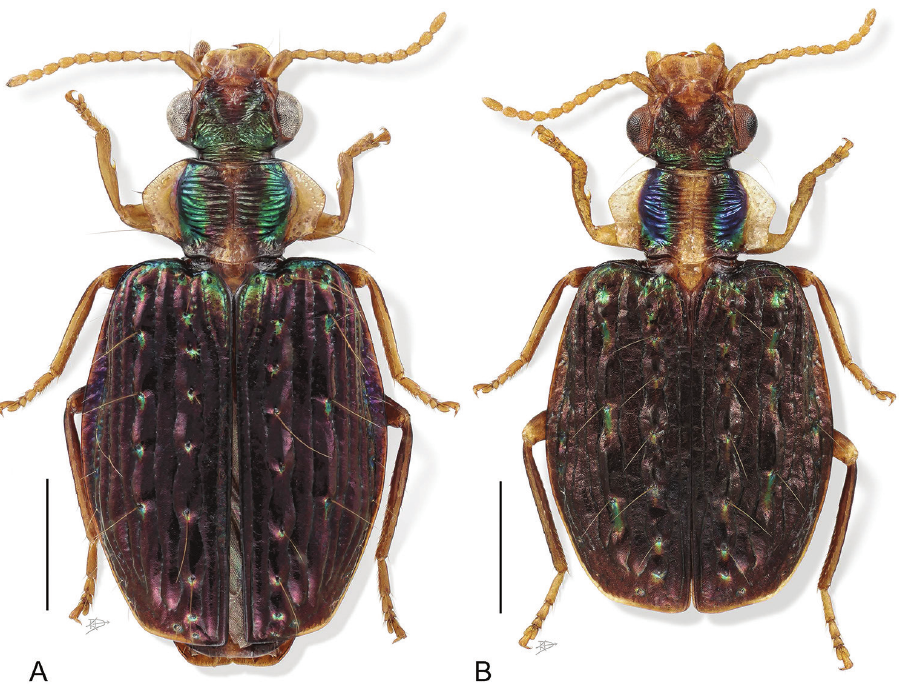
Figure 4. Digital Photo-illustration. Habitus, dorsal aspect. A Hyboptera tiputini Erwin & Henry, sp. n., male, ADP135850 B Hyboptera viridivittis Chaudoir, male,